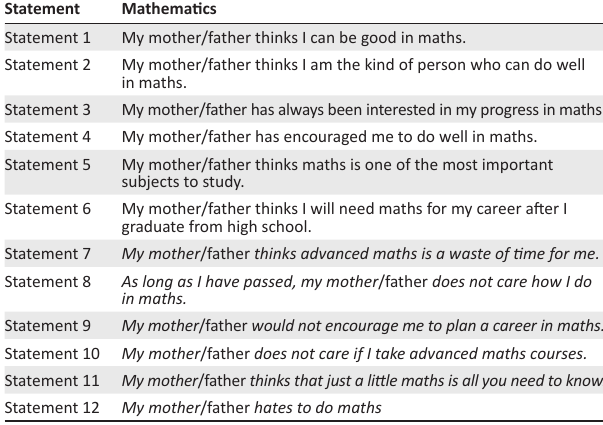
(Table 2): Composite statement: My teacher supported and affirmed my efforts in mathematics. TABLE 1: Mother’s/father’s encouragement and support